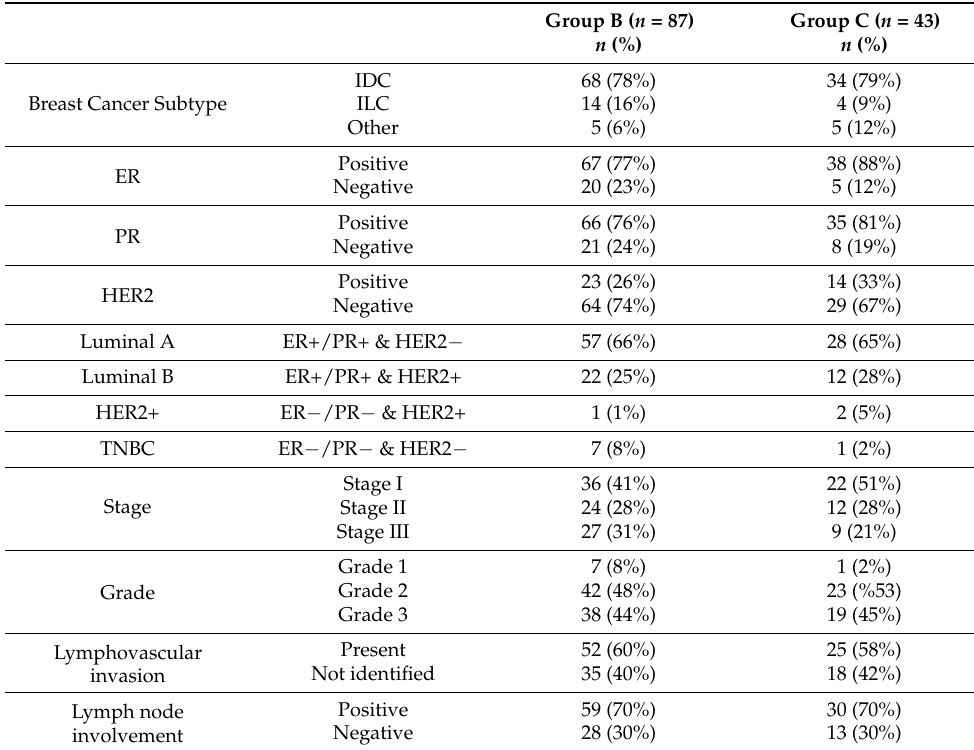
Table 1. Description of the clinicopathological characteristics of invasive breast cancer samples. Group B represents patients with invasive breast carcinoma that were not exposed to neoadjuvant chemotherapy (NAC). Group C represents patients with invasive breast carcinoma that were exposed to NAC. Groups B and C include unmatched sets of tumor samples from independent groups of patients. The table demonstrates the clinicopathological characteristics of groups B and C including histopathological subtyping, molecular subtyping, stage, grade, lymphovascular invasion and lymph node status. Other breast cancer subtypes include invasive metaplastic carcinoma, invasive mixed ductal and micropapillary carcinoma, invasive multifocal mixed ductal and micropapillary carcinoma, metaplastic breast cancer, mixed invasive lobular and ductal carcinoma. Abbreviations: ER: Estrogen Receptor; PR: Progesterone Receptor; HER2: Human Epidermal Growth Factor Receptor 2; TNBC: Triple Negative Breast Cancer.